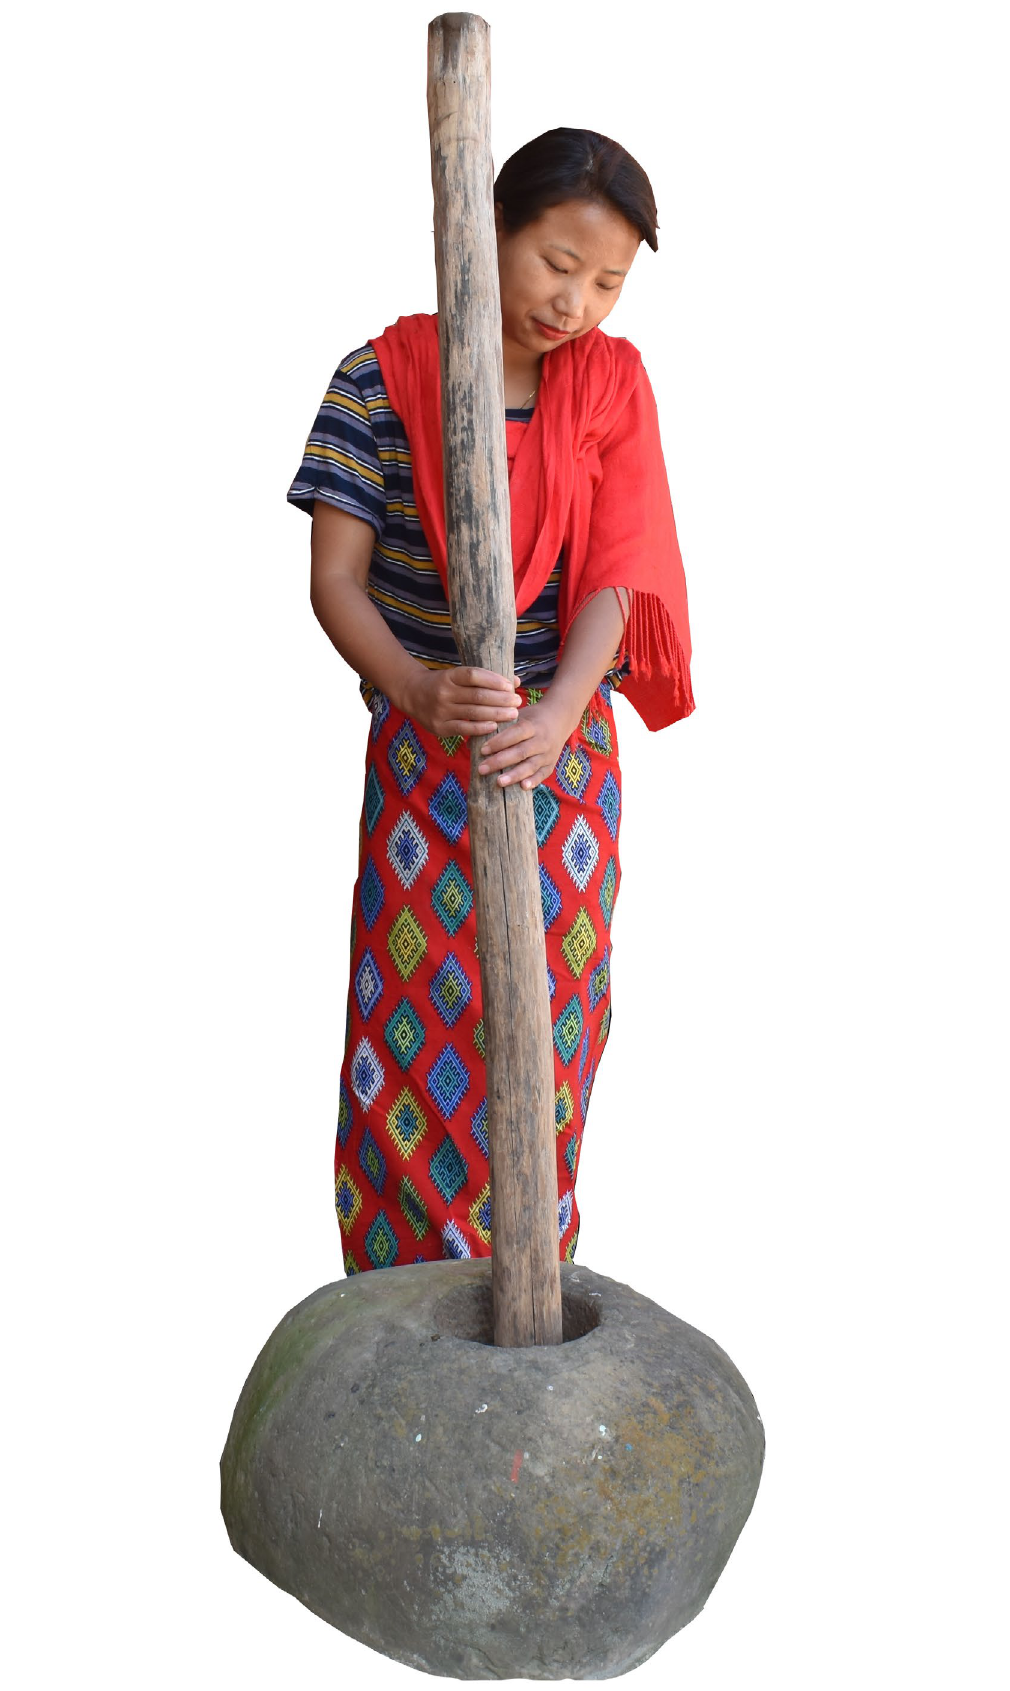
Figure 6. Shertukpen girl pounding corn grains in a nutting stone (Photo by N. J.